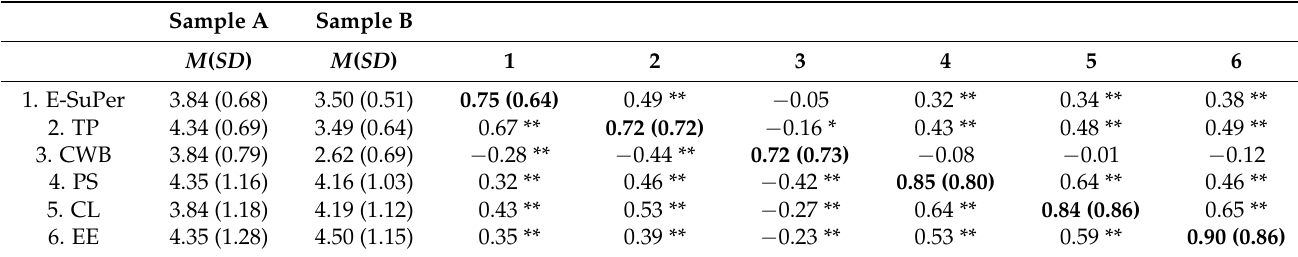
Table 3. Descriptive statistics and zero-order Pearson correlations for Sample A (below the diagonal, n = 153) and for Sample B (above the diagonal, n =